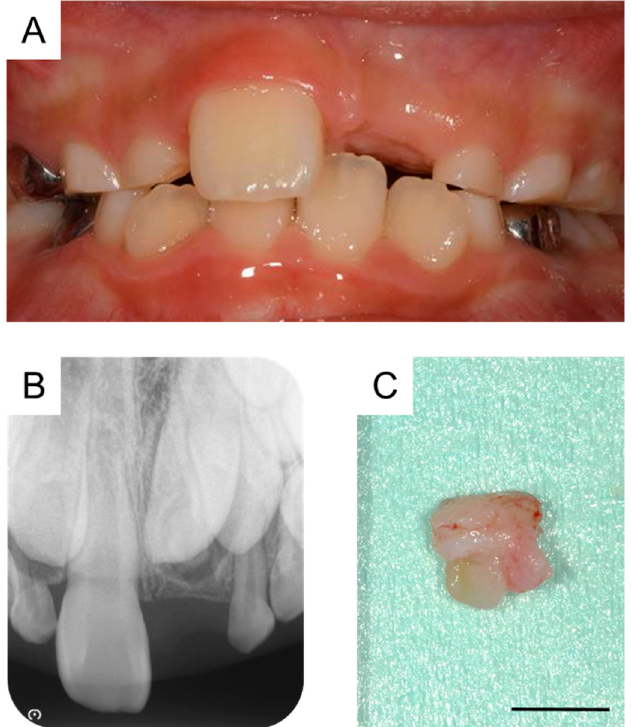
Figure 3. Extraction of the third supernumerary tooth. ( A ) Intraoral photograph at the age of 8 years and 2 months. ( B ) Periapical radiograph showing the third supernumerary tooth at the age of 8 years and 2 months. ( C ) Extracted calcified tissue, which was later diagnosed as the third supernumerary tooth. Scale bar: 5 mm.